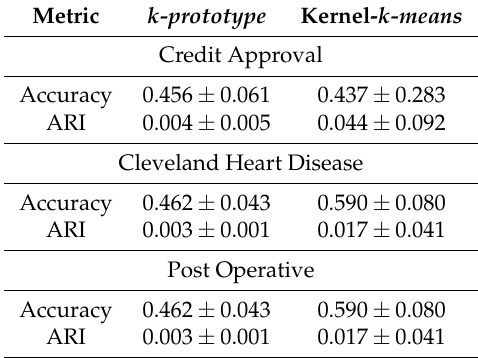
Table 5. Comparison of k-prototype and Kernel- k-means algorithm datasets with mixed data